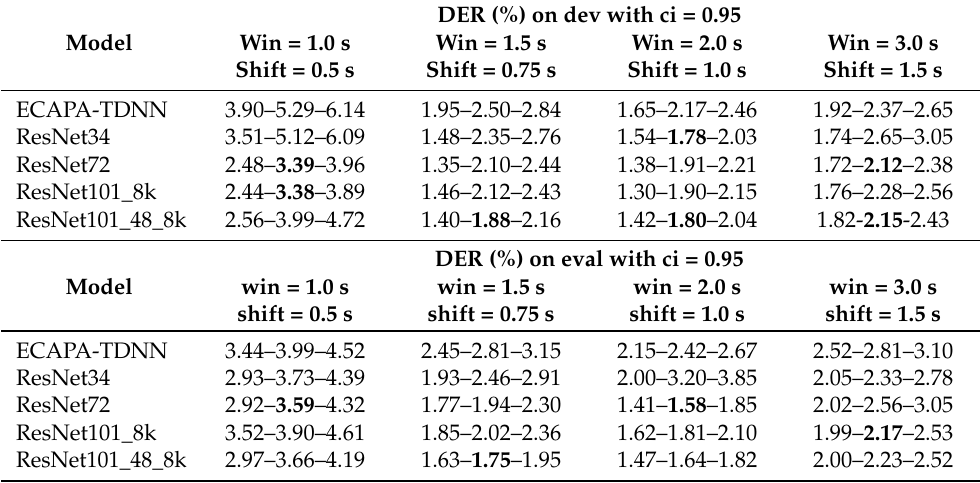
Table 3. Results of investigated systems for AMI Development and Evaluation sets (dev/eval) in terms of DER (%) depending on the set sliding window and shift duration values. Lower error values are better. Upper and lower 0.95 confidence intervals are indicated with a